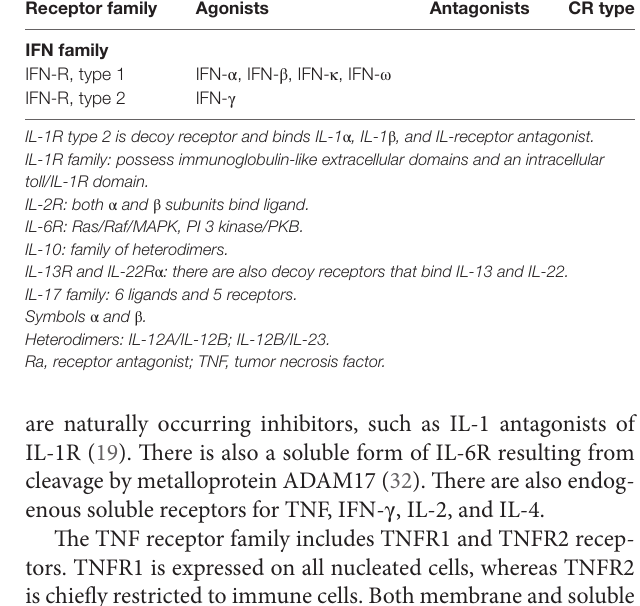
TABle 1 | Cytokine receptors (CR) and endogenous agonists and antagonists. Receptor family